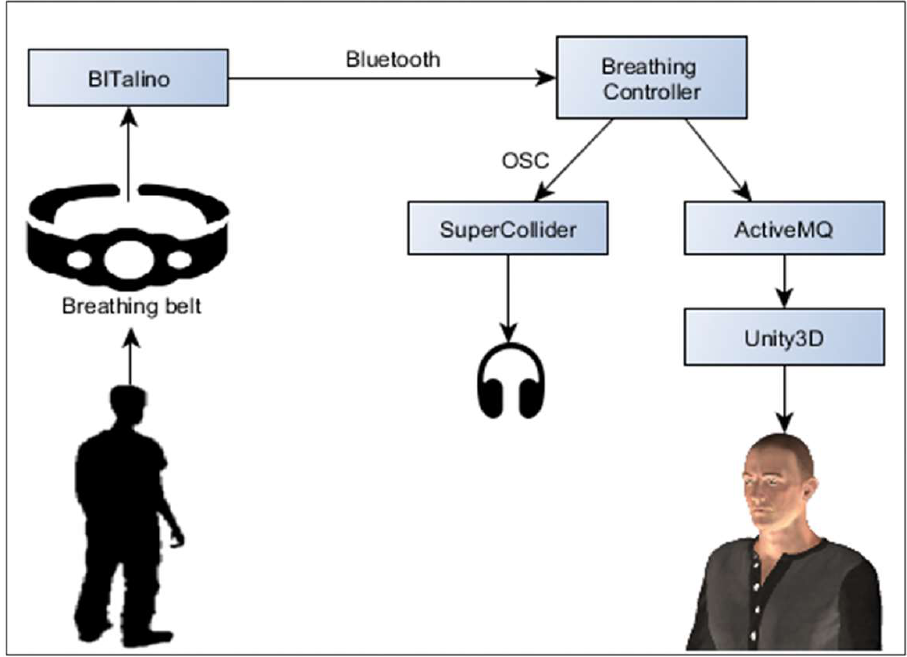
Figure 8. Architecture of the Virtual Human Breathing Relaxation System (VHBRS).